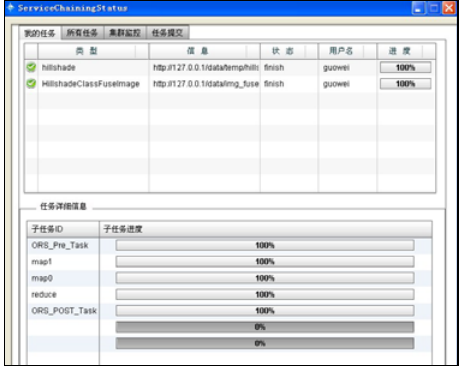
Figure 4. Execution status of demo model